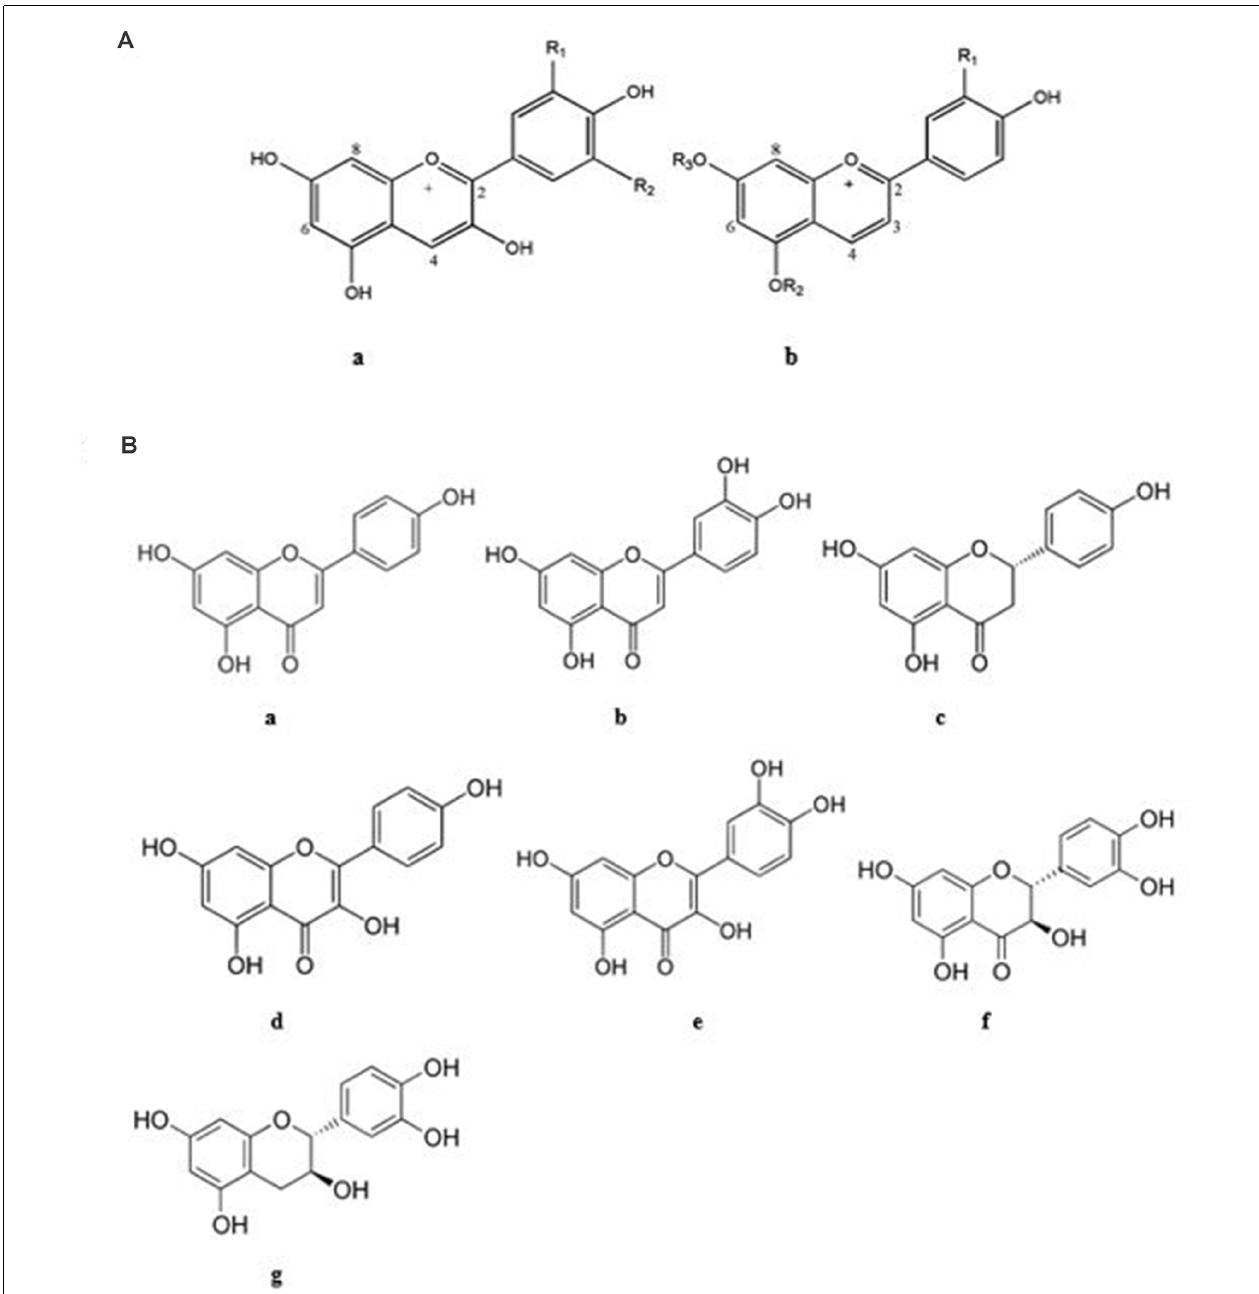
FIGURE 6 | Chemical structure of important flavonoids of sorghum with anti-AD activities. (A) Anthocyanidins ( a : R 1 = R 2 = OCH 3 : malvidin, R1 = OH, R2 = H: cyanidin, R1=OCH 3 , R 2 = H: peonidin, b : R 1 = H, R 2 = H, R 3 = H: apigeninidin, R 1 = H, R 2 = Glc, R 3 = H: apigeninidin-5-glucoside, R 1 = H, R 2 = H, R 3 =CH 3 : 7- methoxyapigenindin, R 1 = OH, R 2 = H, R 3 = H: luteolinidin, R 1 = OH, R 2 = Glc, R 3 = H: luteolinidin-5-glucoside, R 1 = OH, R 2 =CH 3 , R 3 = H: 5-methoxyluteolinidin), (B) others ( a : apigenin b : luteolin c : naringenin d : kaempferol e : quercetin f : taxifolin g : catechin; Awika et al., 2005; Lakey-Beitia et al., 2015; Vanamala et al.,